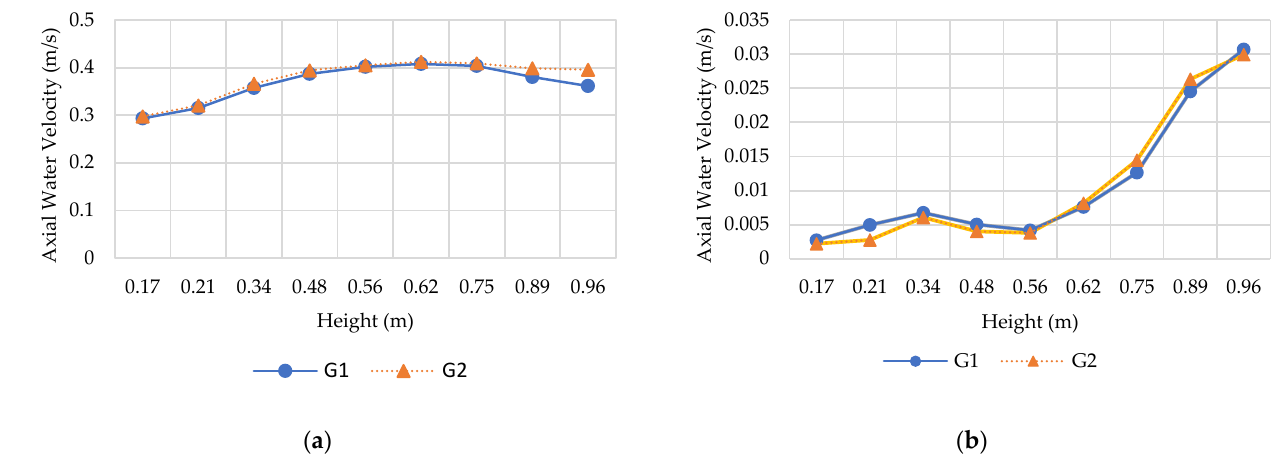
Figure 7. ( a ) Axial velocity in riser of geometries 1 and 2 based on 9 sampling points; ( b ) Axial velocity (absolute value) in downcomer of geometries 1 and 2 based on 9 sampling points.